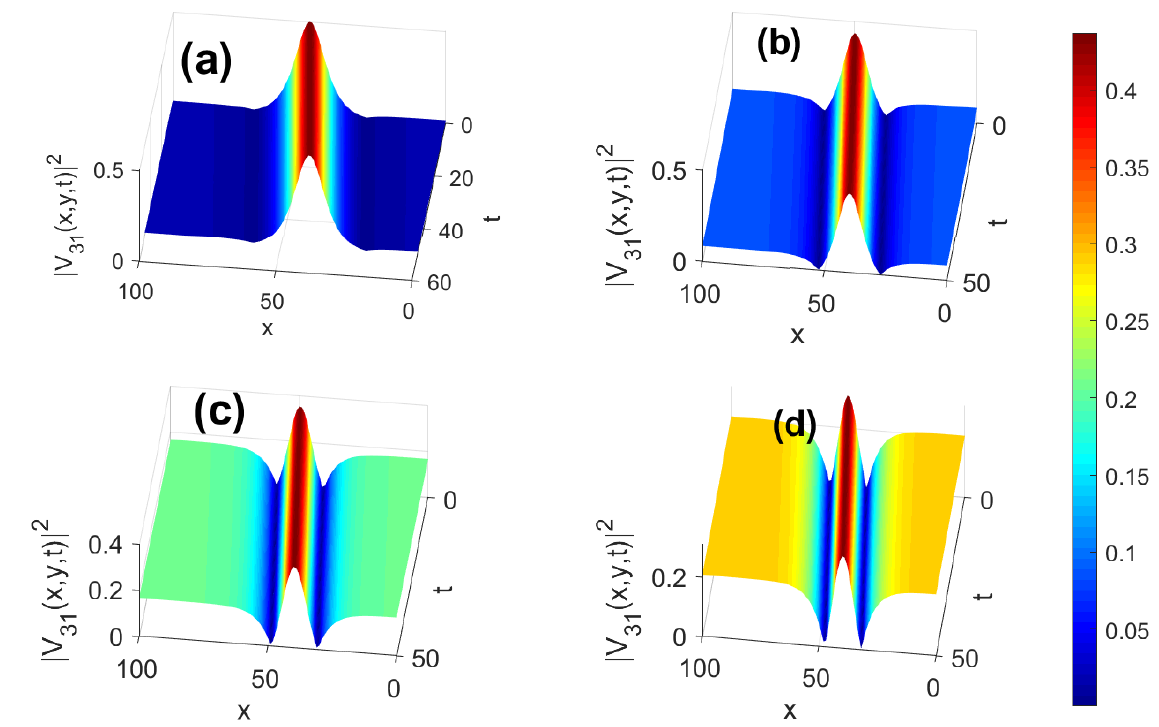
Figure 2. ( a , b ) Spatiotemporal evolution of the bright soliton and ( c , d ) W-SP with variation in the potential parameter α . ( a – d ) are, respectively, the values of the potential α = 0.22 V − 1 , B 1 = 0.02, y = 0.